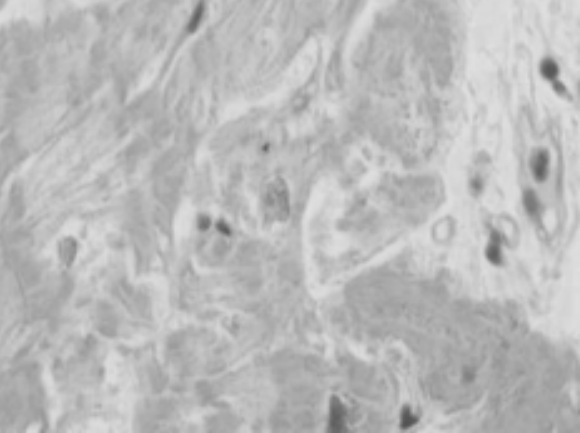
Figure 5. Microphotography of the peri-stent myocardium showing cardiac muscle degeneration and necrosis, denoting an acute process. (hematoxylin-eosin; 400X